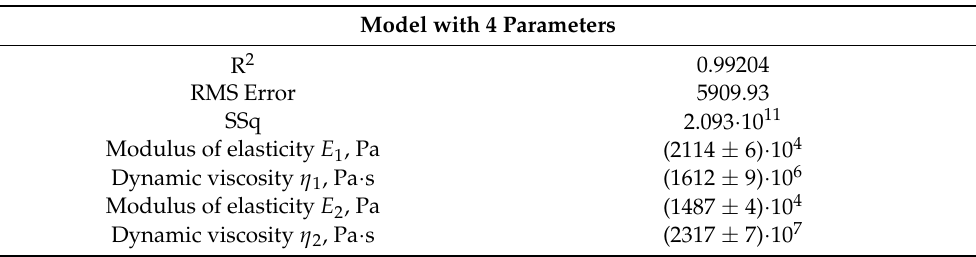
Table 2. Values of parameters in a generalized Maxwell model with four parameters for unaged asphalt binder containing 4.5% SBS.